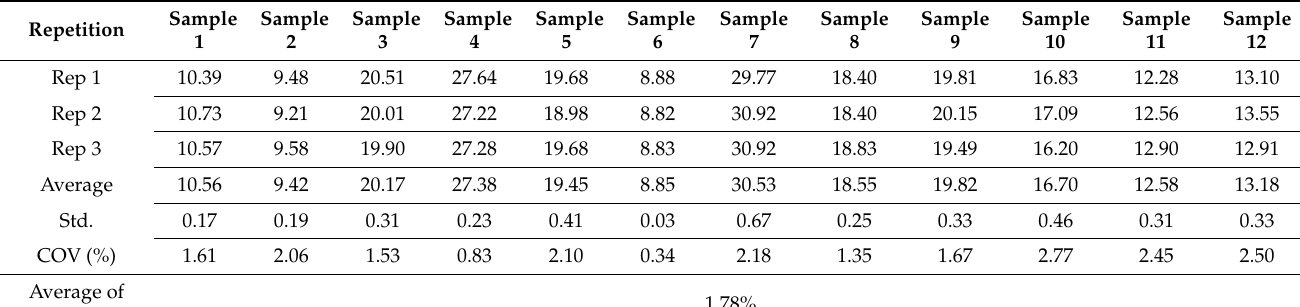
Figure A6. Comparison of TXM and CHIP concentration profiles for all other 10 concrete samples. The numbers next to each graph, show the sample name. Table A2. Diffusion coefficient of 12 concrete samples tested three times from the same side (D ac × 10 − 12 m 2 /s).